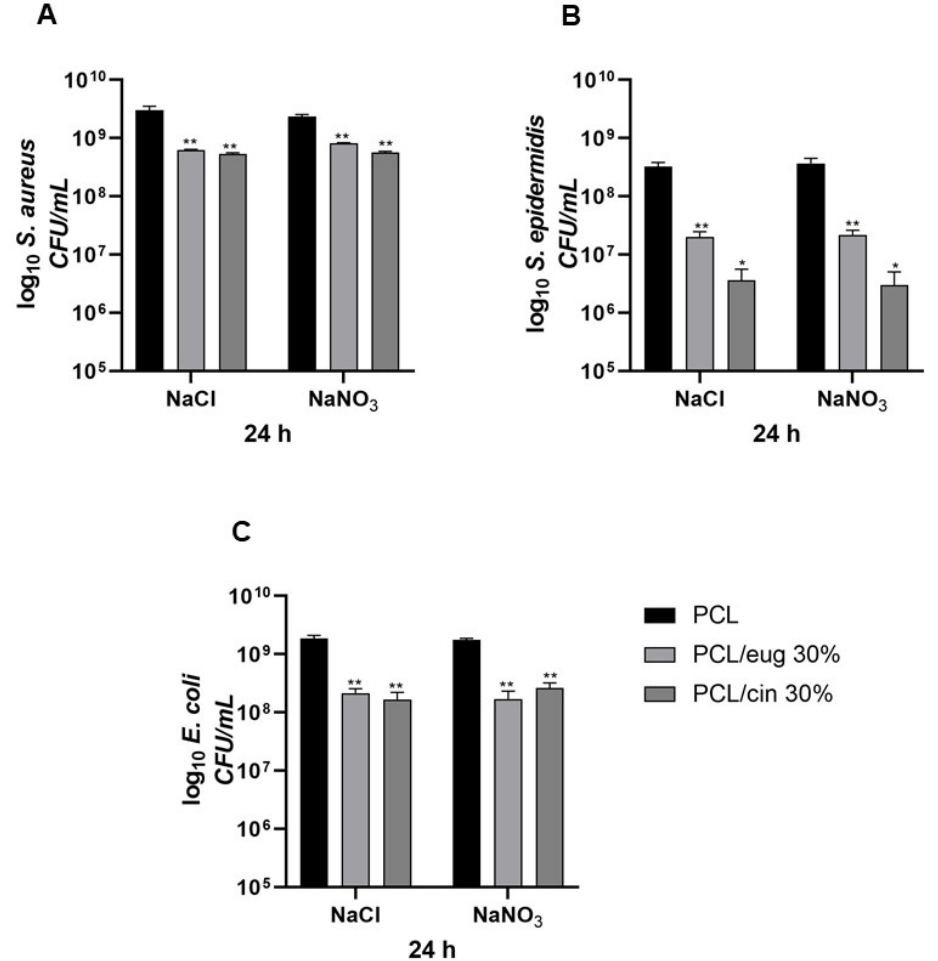
Figure 11. Number of planktonic S. aureus ( A ), S. epidermidis ( B ) and E. coli ( C ) (log 10 colony forming unit, CFU/mL) on the PCL scaffolds added with 30% eugenol or cinnamon oil, produced with either NaCl or NaNO 3 salts, after 24 h of incubation. Results are the mean values ± standard error of the mean (SEM) of at least three independent experiments. ** p < 0.05 or * p < 0.001 vs. PCL, unpaired t - test.